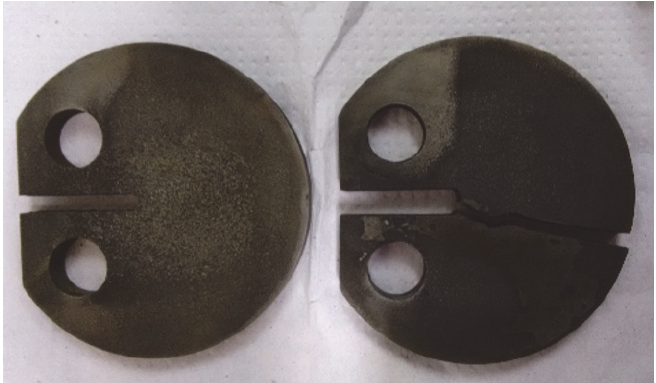
Figure 7: LE specimens after working 30 days under EAC conditions in an aqueous hydrogen sulfide